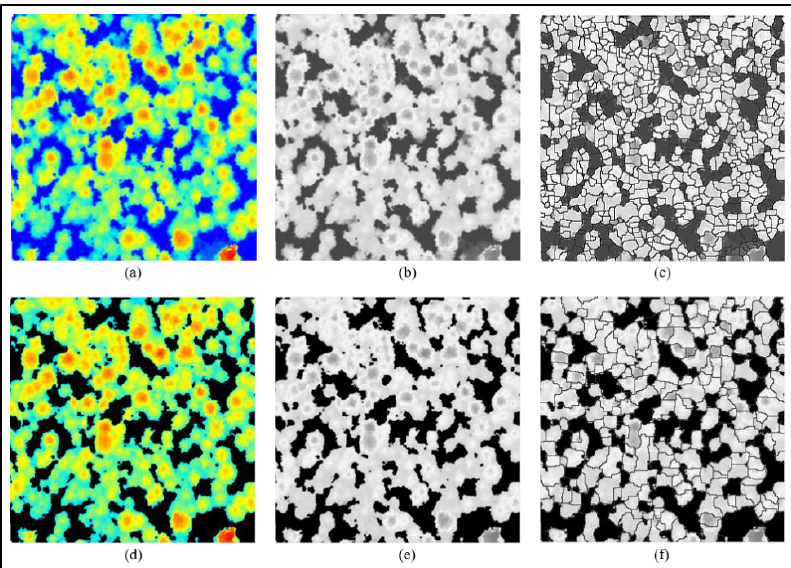
Figure 5 . Comparison of experimental results of traditional watershed and improved watershed: (a) CMM model, (b) gray scale display CMM model, (c) watershed algorithm, (d) K-means clustering based on 𝐶𝑀𝑀 , (e) gray scale display CMM K-means